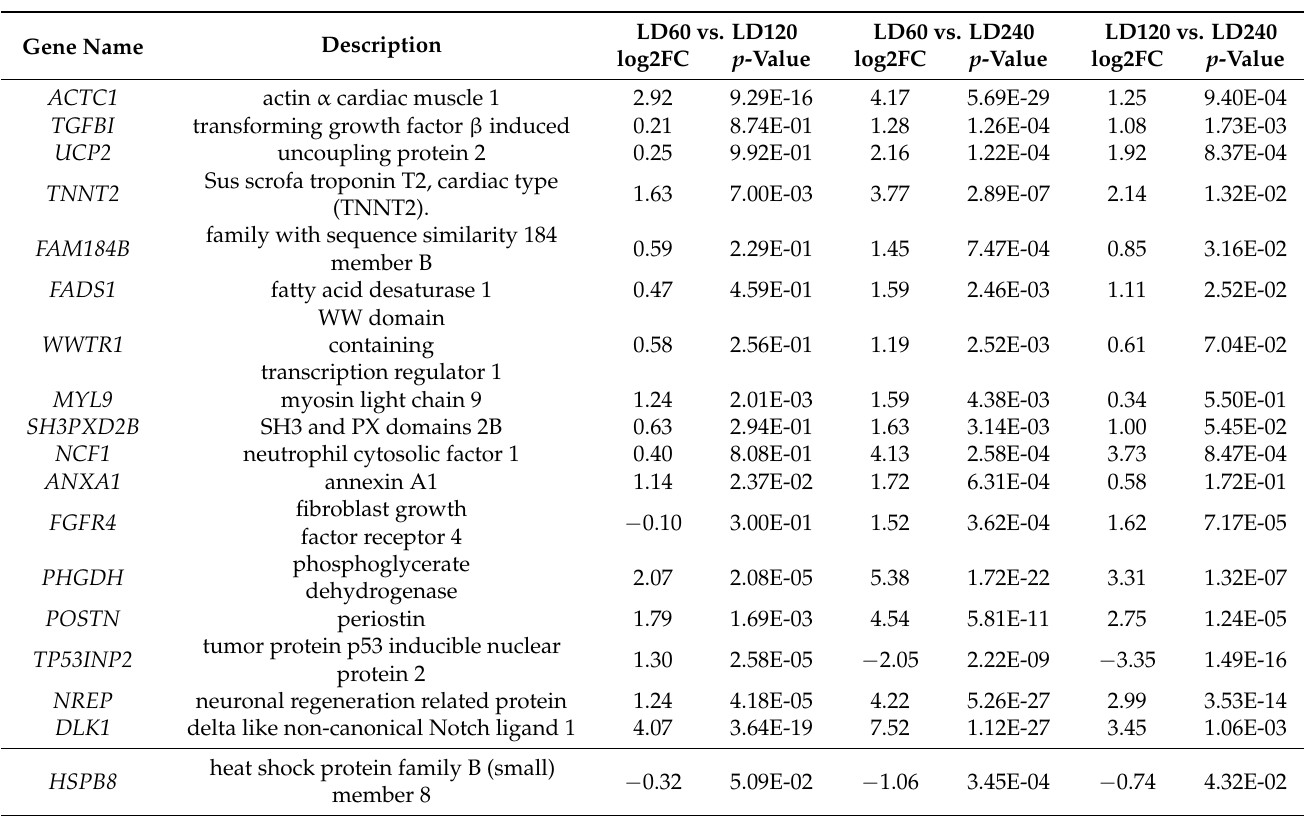
Figure 4. Hierarchical cluster analysis of 9 samples from three developmental stages of WH pig and expression heatmaps of DEGs at different developmental stages. ( a – c ) LD60 vs. LD120, LD120 vs. LD240, LD60 vs. LD240. ( d ) Heatmaps of IMF adipose-related DEGs at different developmental stages. Table 3. Differentially expressed genes associated with IMF deposition at different developmental stages of WH